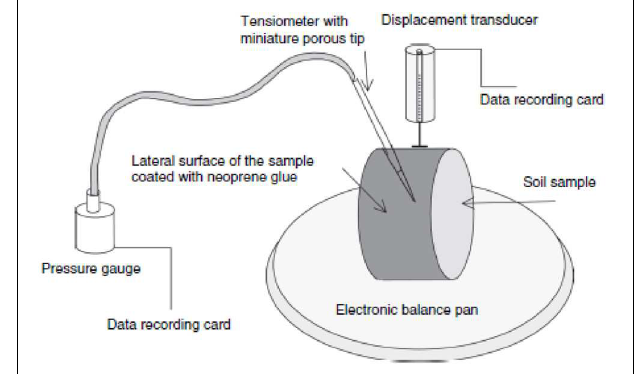
FIGURE 4 | Device used by Braudeau and Mohtar (2004) for the simultaneous measurement of the soil water retention and soil shrinkage curves of a cylindrical soil